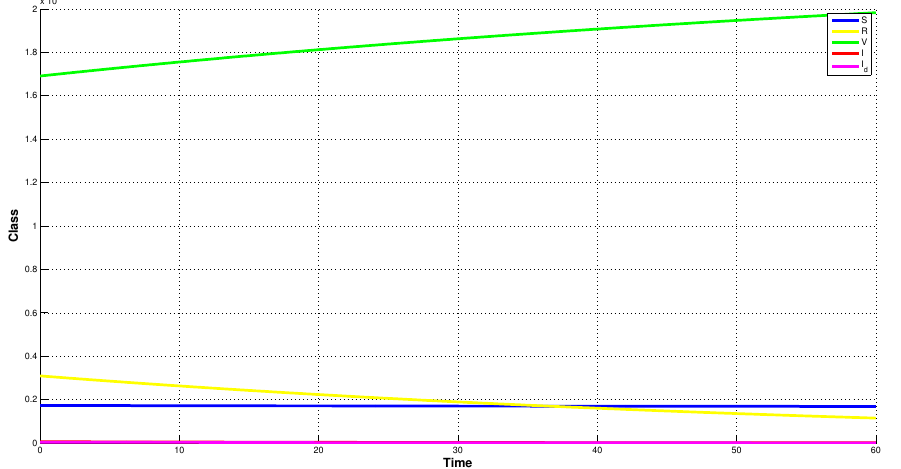
Figure 2. Numerical simulation for system (2) using (19) and (20).